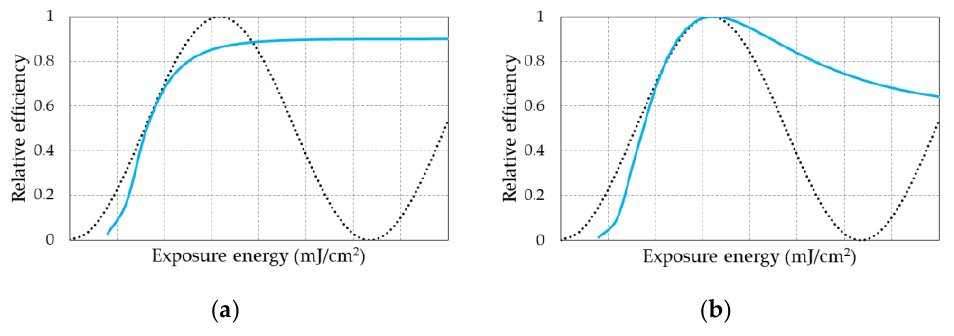
Figure 4. Efficiency vs. exposure curves for different values of n 1, max . Black dots represent theoretical dependence of Equation (8), assuming linear dependence of index modulation with exposure. The blue curve represents the dependence when the index modulation reaches a saturation value n 1, max : ( a ) n 1, max is not enough to reach 100% efficiency and ( b ) n 1, max is higher than the index modulation value needed to obtain 100% efficiency (overmodulation).